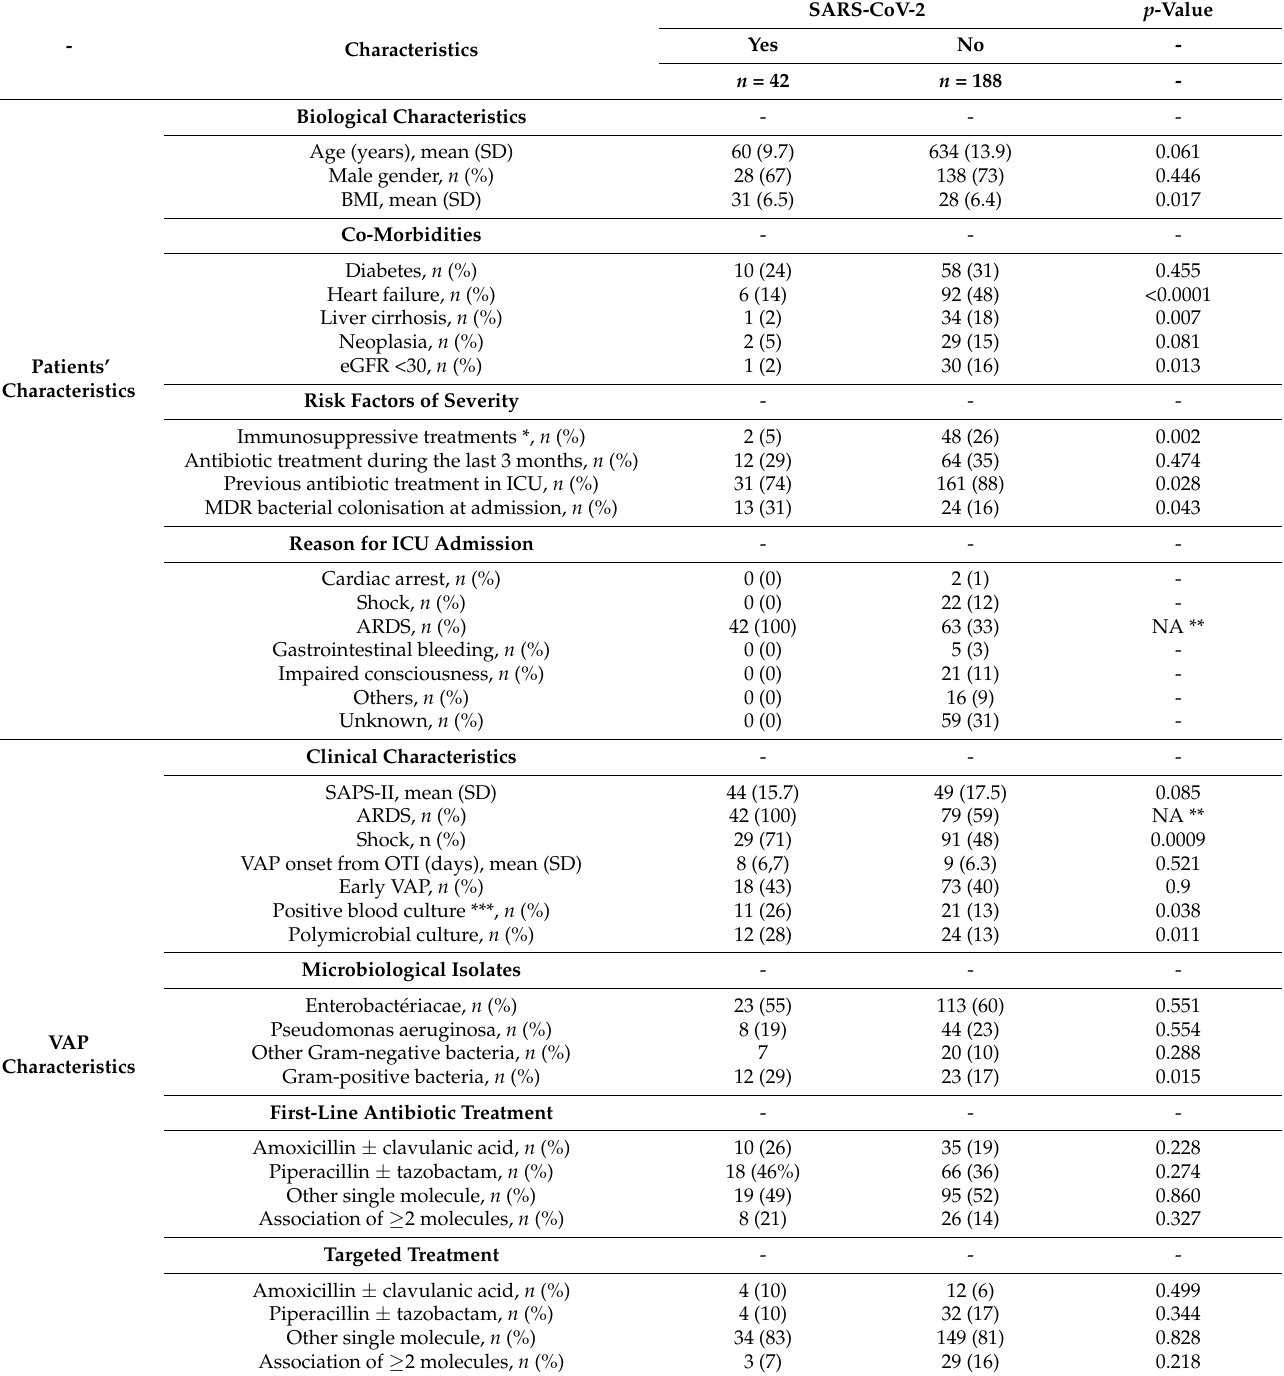
Table 1. Characteristics of VAP occurring in patients with or without SARS-CoV-2